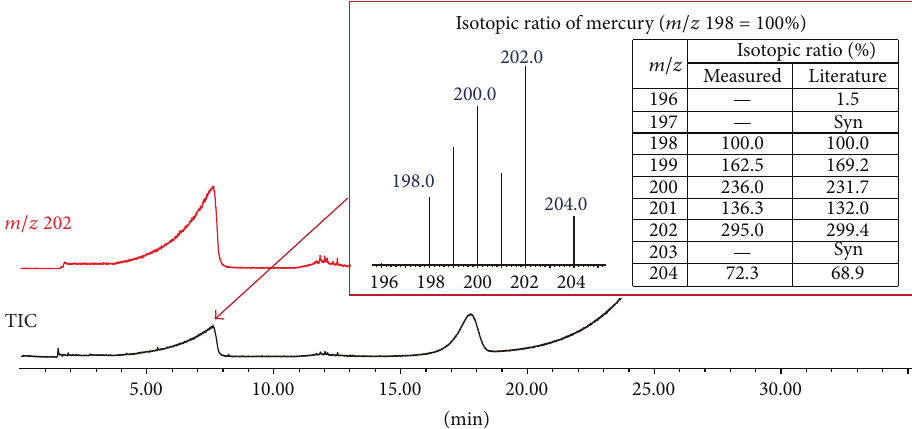
Figure 9: TIC and ion chromatograms of the 𝑚/𝑧 202 fragment ion of standard HgS